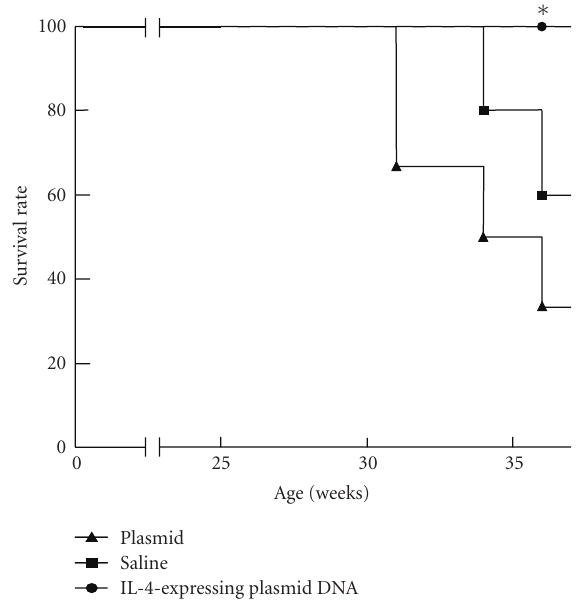
Figure 4: Survival rate among three groups. Mice were treated intraperitoneally either with 100 μ g of the IL-4pDNA, 100 μ g of plasmid only or saline only at the age of 4, 6, 8, 12, 16, 20, 24, 28 and 32 weeks. ∗ P < . 001 (comparison between the IL-4pDNA group and two controls). Provided here is courtesy of NDT 2007, 22, 3131-8: Oxford University